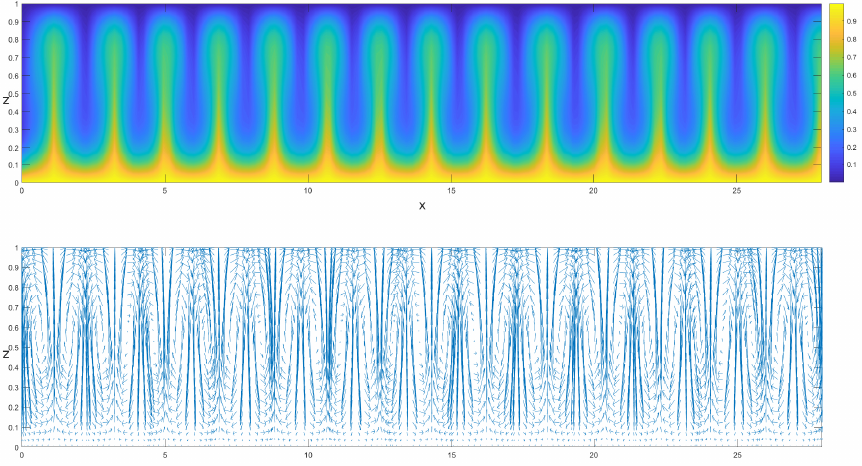
Figure 10. Isotherms and velocity field of the numerical solution obtained with alternating Schwarz; R = 5000 and Γ =